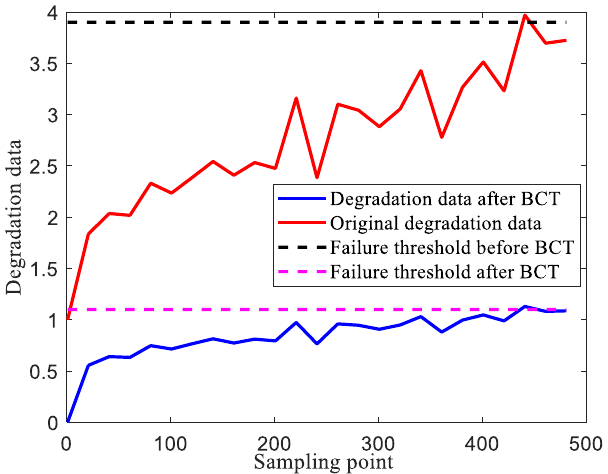
Figure 7. Degradation trajectory before and after BCT .